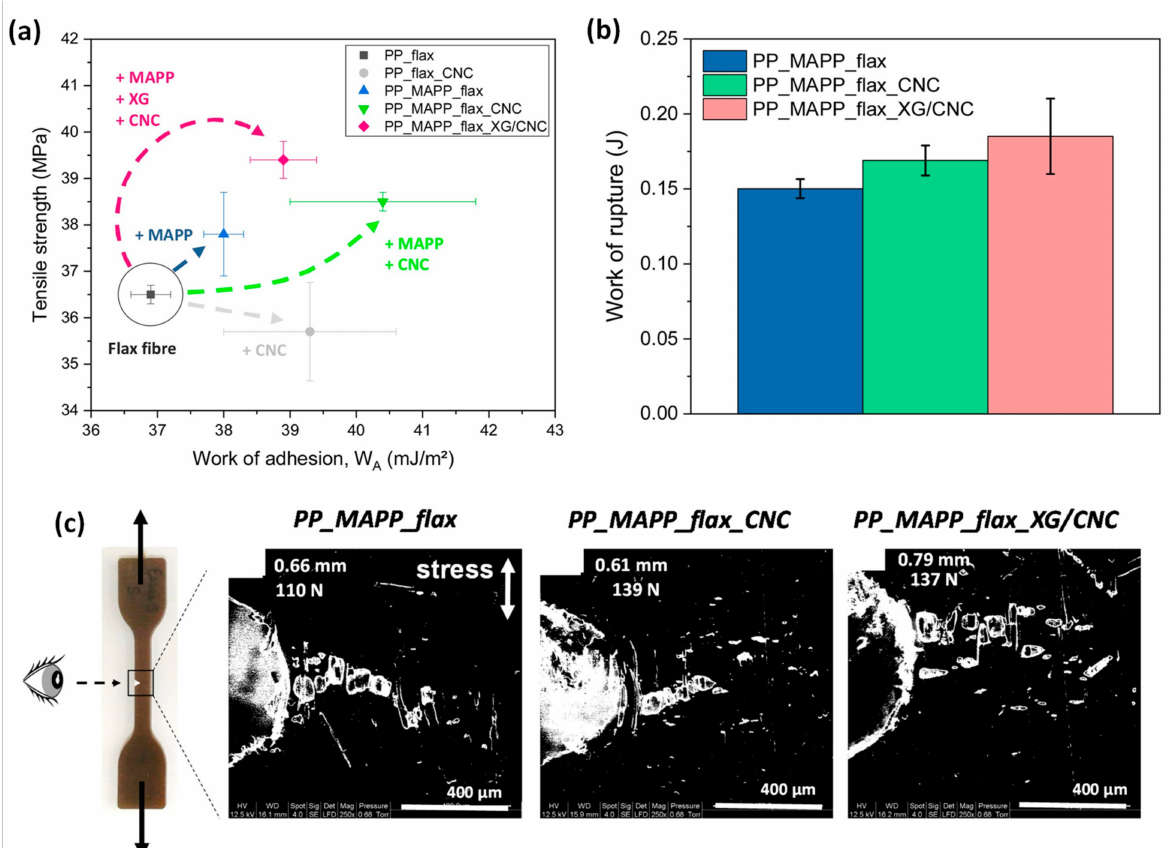
Figure 23. ( a ) Tensile strength by uniaxial tensile tests for the different biocomposites at 20 wt% flax fibres versus the calculated work of adhesion W a (Wu approach) between flax fibres and matrix; ( b ) work of rupture of micro-tensile tests for two notched specimens with 20 wt% non-treated or CNC and XG/CNC modified flax fibres and PP/MAPP matrix with ( c ) resulted SEM observations during crack propagation in these notched specimens (reprinted with permission from Doineau et al., 2021